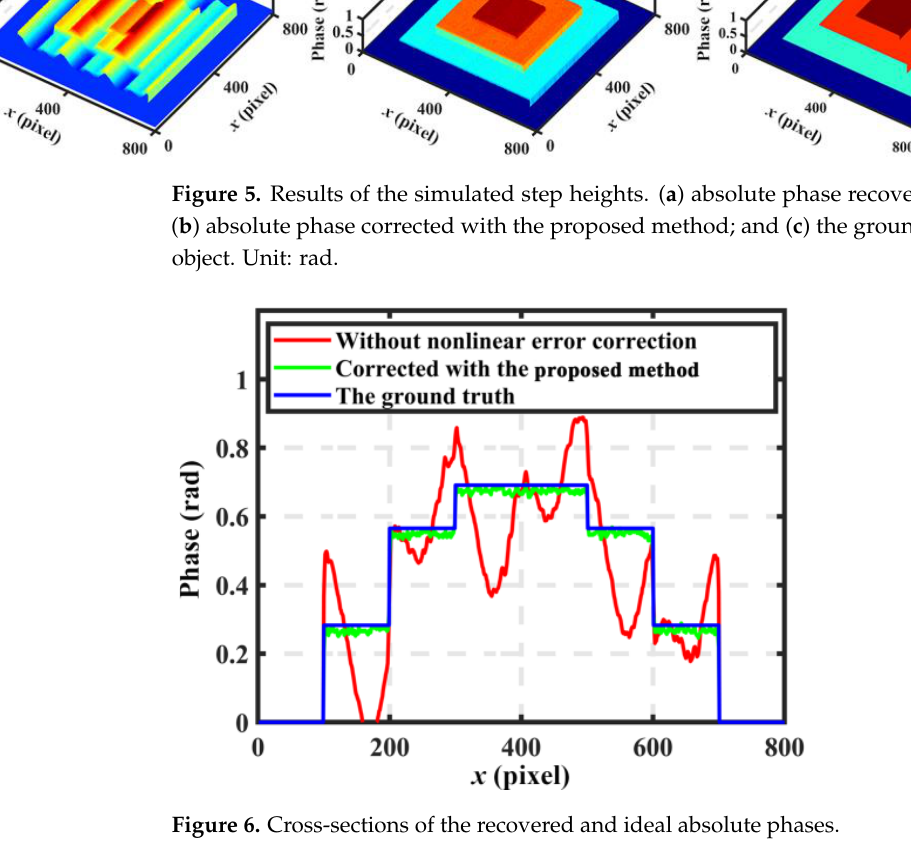
Figure 6. Cross-sections of the recovered and ideal absolute phases. To explore the influence of the number M on the correction results, the residual errors under different M values were computed. Figure 7a illustrates the nonlinear error before PPD adjustment within one fringe period, and the RMS error was about 0.192 rad. Figure 7b–f illustrate the residual errors after PPD adjustment with different M values, and the corresponding RMS errors are also given. Further, Figure 8 plots the RMS error curve of the residual errors with respect to different M values ranging from 50 to 1000. In particular, the RMS residual error decreased to 0.061 rad when M = 50, 0.041 rad when M = 100, 0.033 rad when M = 200, 0.032 rad when M = 500, and 0.031 rad when M = 1000. It is obvious that the RMS residual error was inversely proportional to M . If M ≤ 500, the RMS residual error degraded quickly from 0.061 to 0.032 rad with the increase of M . If M > 500, the RMS residual error stayed stable with the increase of M , only having a variation of 0.001 rad. The simulation results confirmed that the residual error can be restrained by choosing a relatively larger M value. However, a larger M value always requires higher computation cost; thus, M = 500 was selected in the following